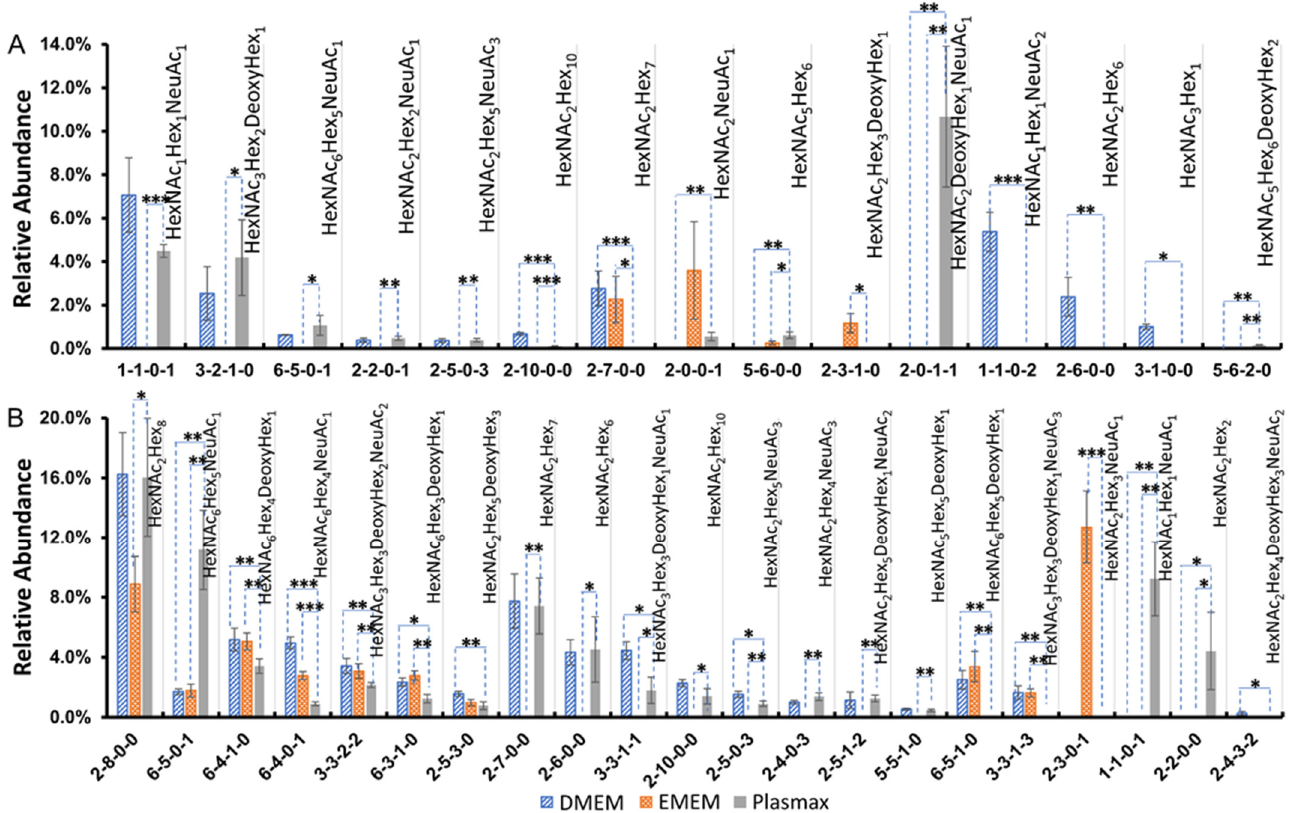
Figure 5. Relative abundance of significant O -glycans derived from ( A ) the 231BR cell line and ( B ) CRL cell line. The four-digit number labeled on the x-axis represents the structure of O -glycans. The first number represents HexNAc, the second represents Hex, the third represents fucose (Deoxy- Hex), and the last represents NeuAc/sialic acid. Each bar represents the mean of three biological replicates; the error bars denote the standard deviation. *: p -value < 0.05; **: p -value < 0.005; ***: p -value < 0.0005.